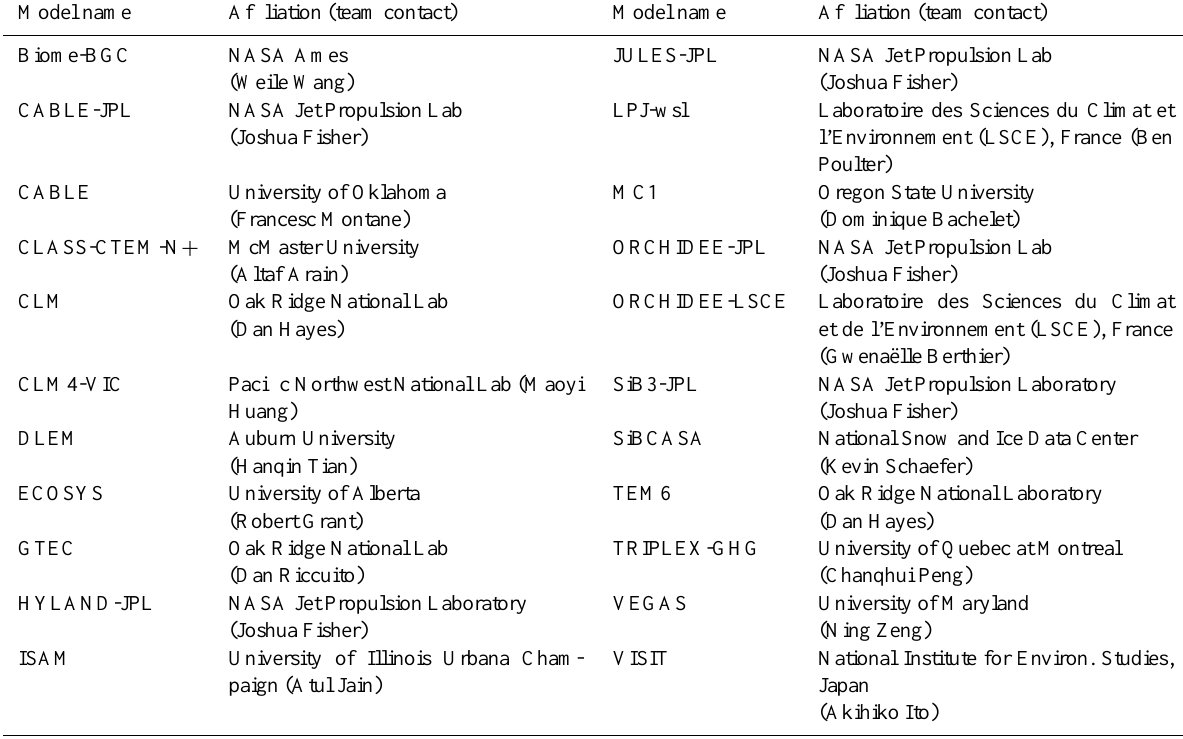
Table 2. Terrestrial biospheric models participating in the MsTMIP activity.